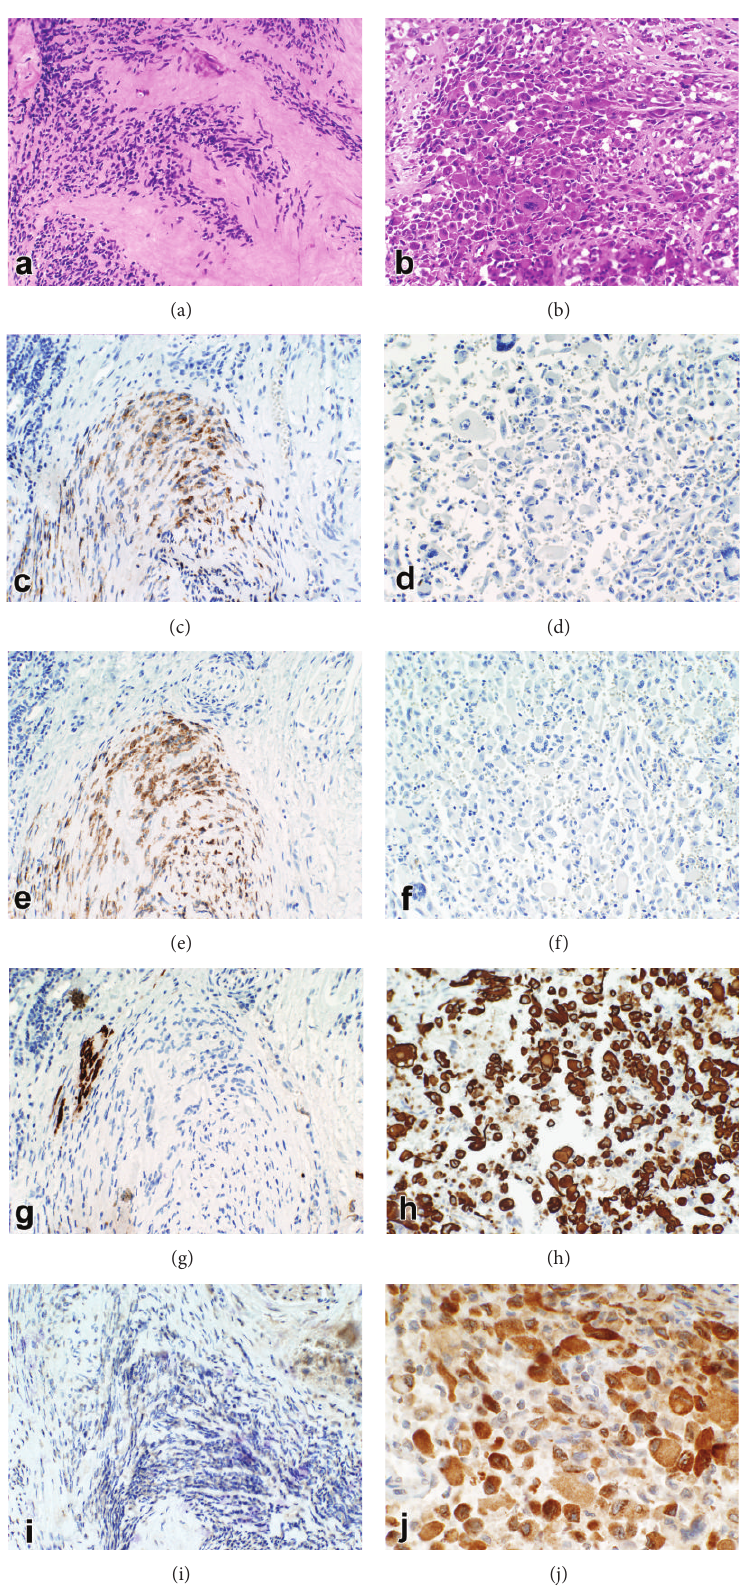
Figure 2: Tumor at the time of en bloc resection. Left panels showing H&E (a, b) and immunophenotype of spindle cell component (a, c, e, g, and i) and right panels showing rhabdomyosarcomatous component (b, d, f, h, and j) as follows: (c, d) c-kit IHC, 200x, (e, f) DOG1 IHC, 200x, (g, h) desmin IHC, 200x, and (i, j) myoD-1,